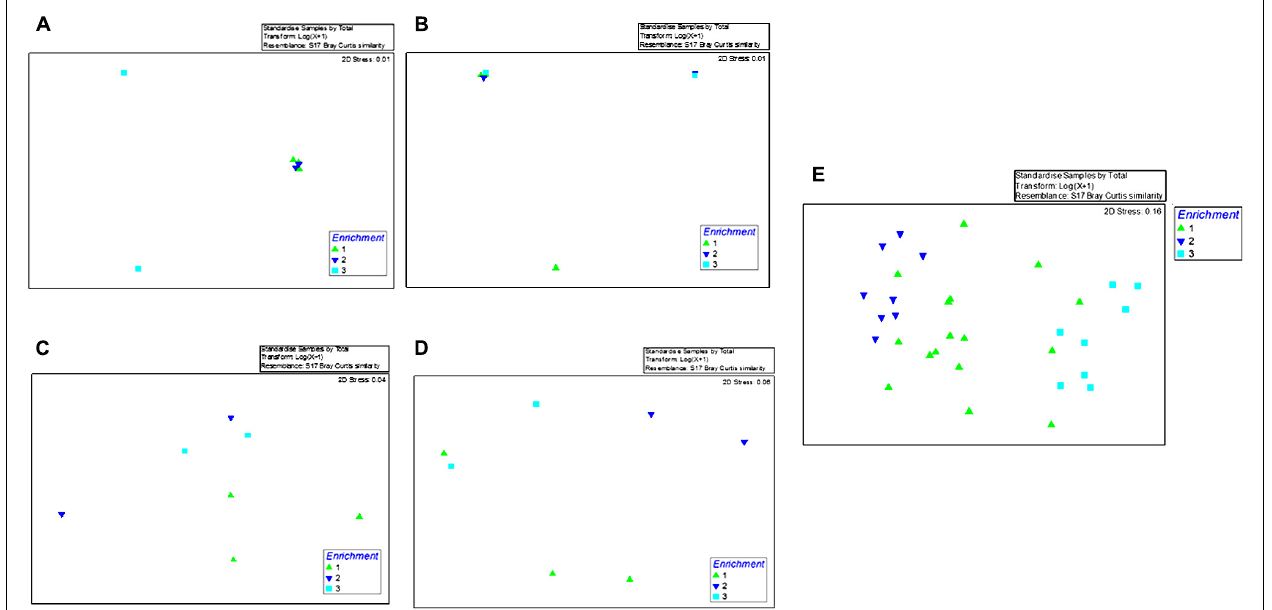
FIGURE 2 | Shown are the non-metric multidimensional scaling plot (NMDS) ofARISA data obtained from the first enrichment phase (E1; green triangle), second enrichment phase (E2; blue triangle), and the third enrichment phase (VE; turquoise square) with enrichment time as